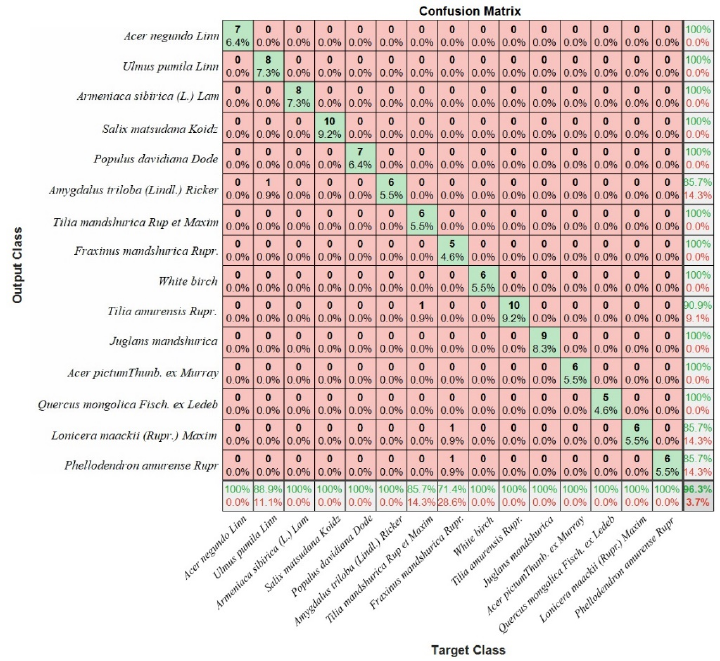
Figure 14. The confusion matrix of leaf small datasets by using GoogLeNet.